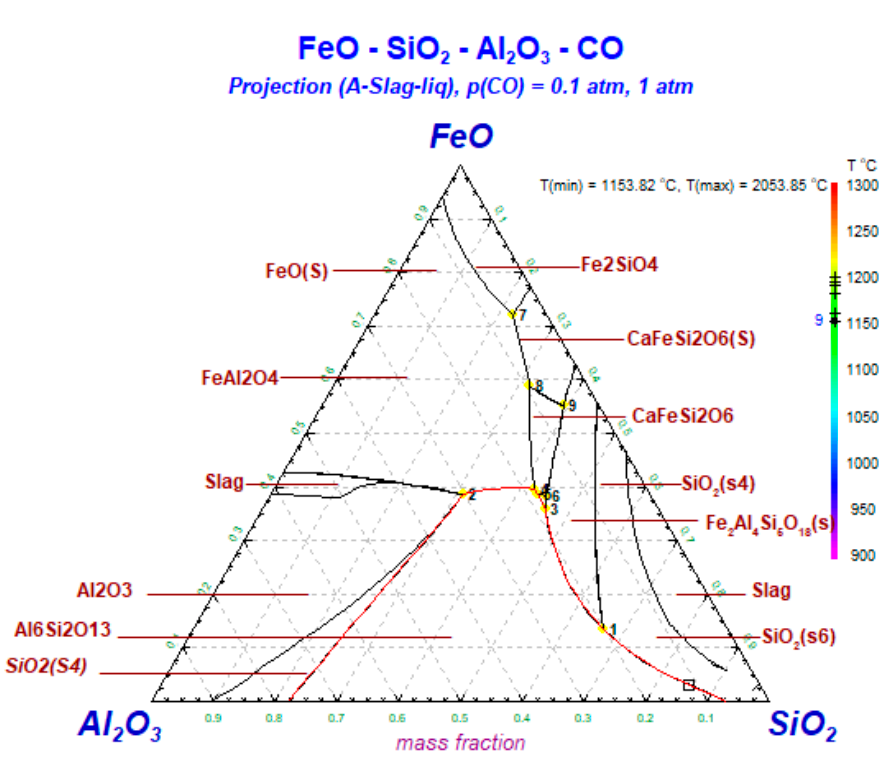
Figure 13. Phase diagram of Al 2 O 3 –SiO 2 –FeO during reduction.